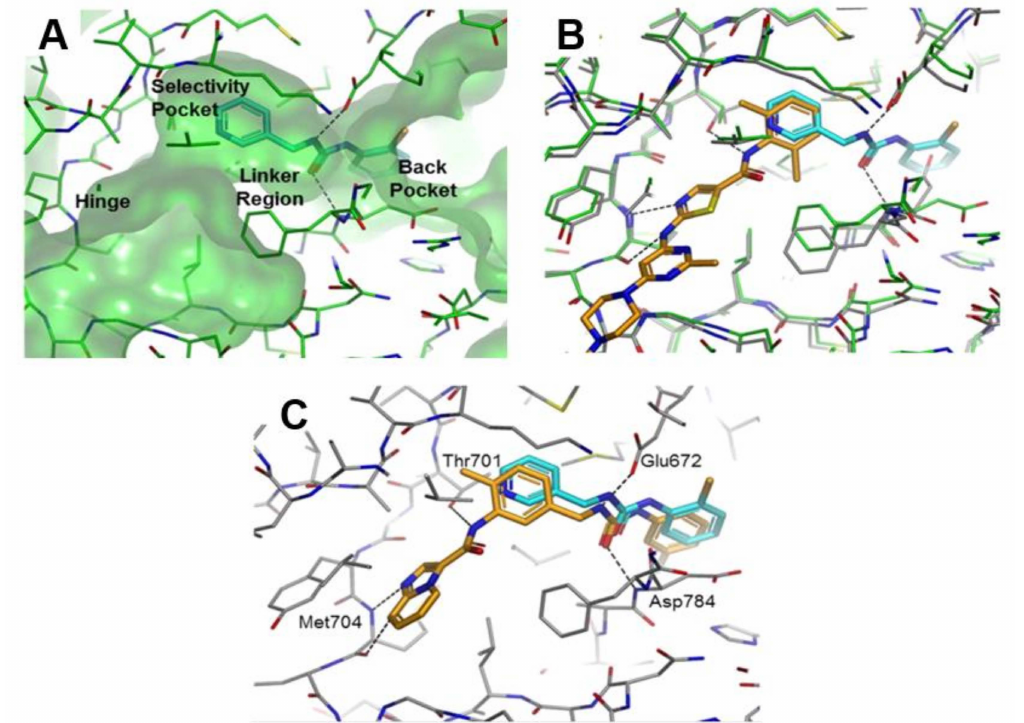
Figure 12. ( A ) Fragment 1 ( 33 ) in DDR1 binding pocket; ( B ) Cocomplex of dasatinib ( 1 ) and fragment 1 ( 33 ) ( C ) Cocomplex of compounds 33 and 34 . Reprinted with permission from Ref. [142].